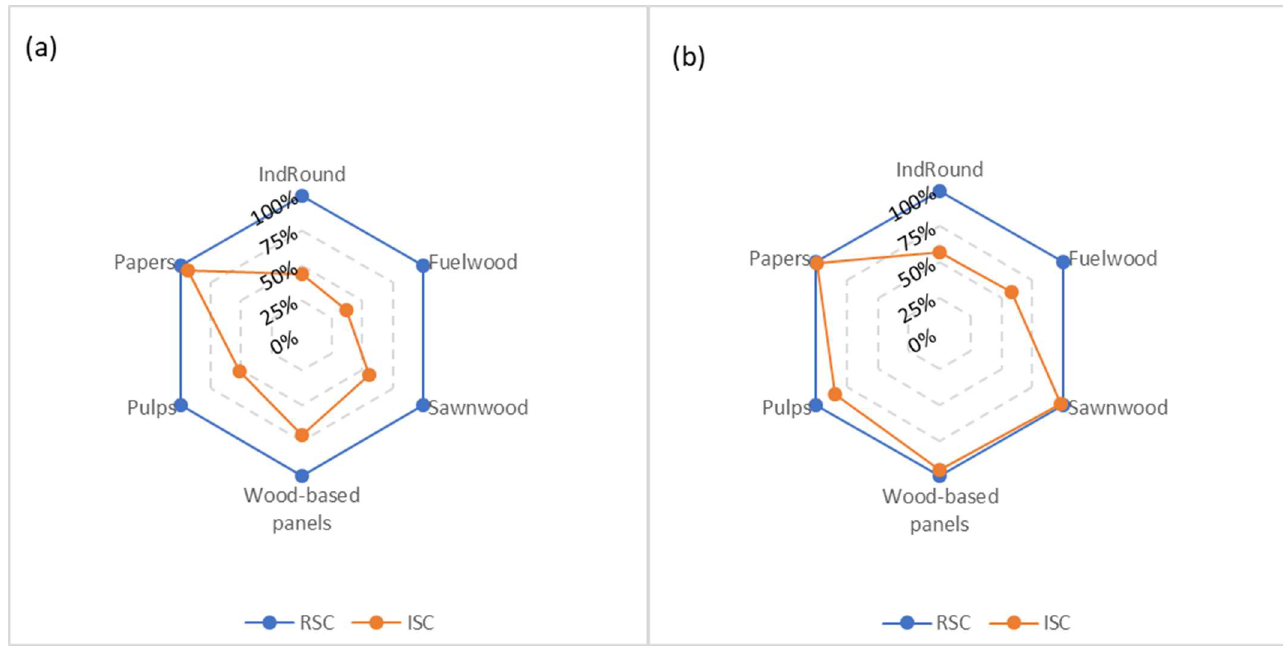
Figure 10. Level of EU production ( a ) and consumption ( b ) of industrial roundwood (IndRound), fuelwood, sawnwood, wood-based panels, pulps and papers in ISC (orange) compared to the RSC (blue). Radar plots mirrors the relative ( a ) production and ( b ) consumption levels in ISC measured to production and consumption of RSC (represented by 100%) in 2050 [authors’ results].